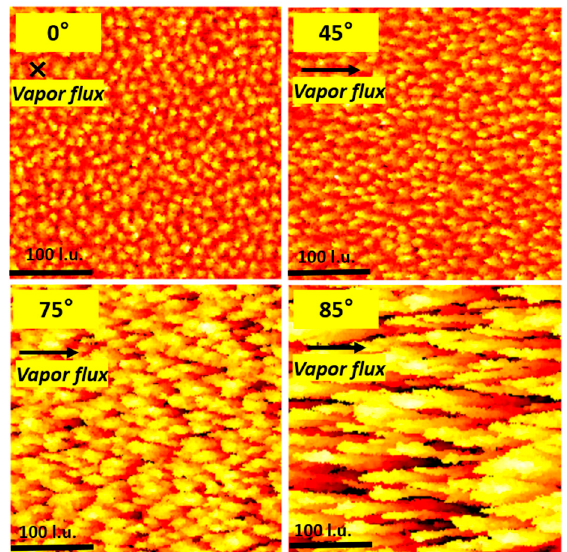
Figure 7. The top views of the initial nanostructure of the silver film under different deposition angles in simulation.